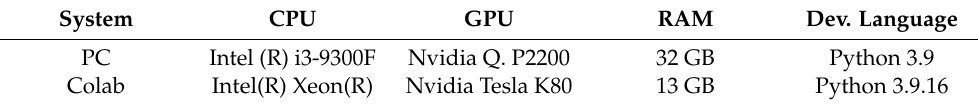
Table 1. Hardware and software specifications of the system used to train and test YOLO